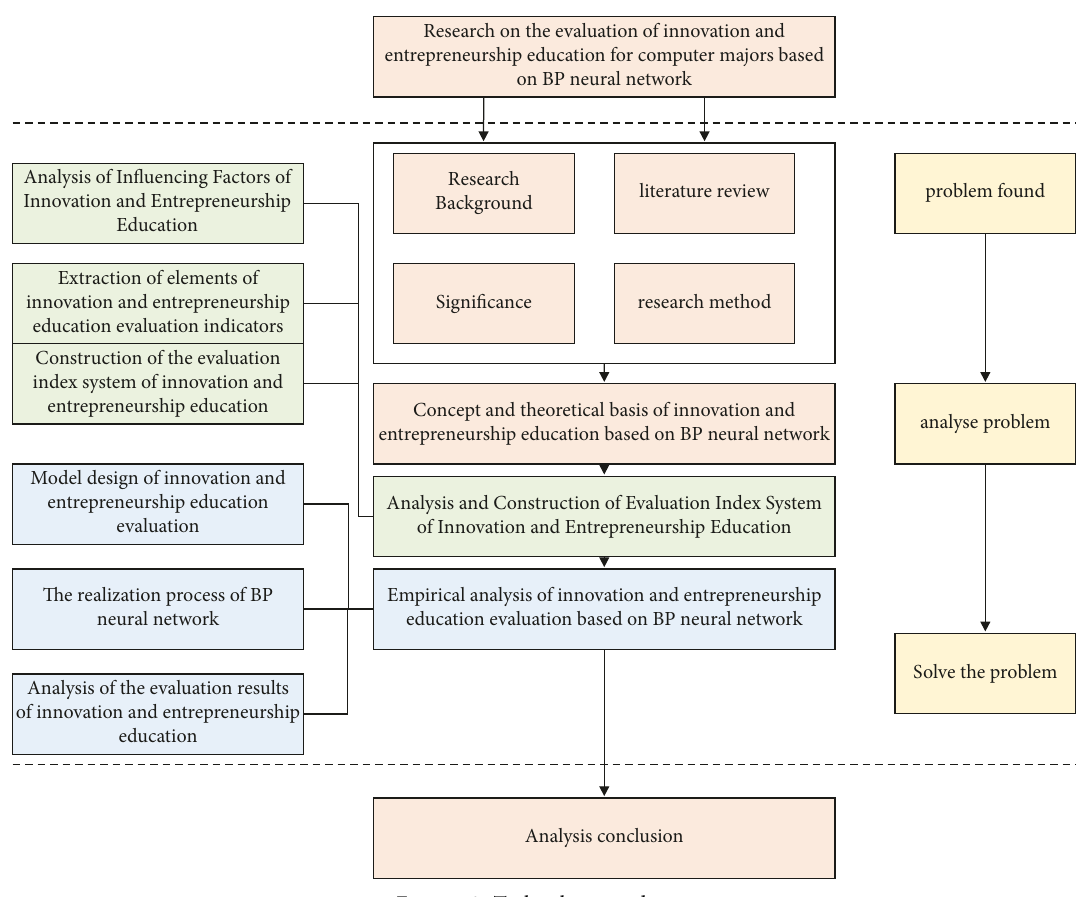
Figure 3: Technology roadmap.